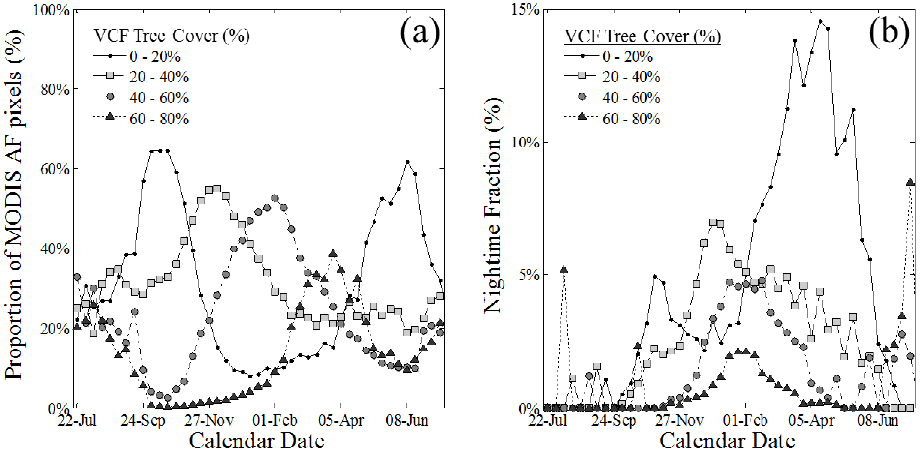
Figure 11. Seasonal profiles of MODIS active fire (AF) pixels detected in the CAR and sorted into 20% intervals of tree canopy cover characterized using the Vegetation Continuous Field (VCF) product [59]. As the dry season progresses ( a ) more MODIS AF pixels are detected under greater canopy cover; and ( b ) a greater proportion of MODIS AF pixels are detected at night.